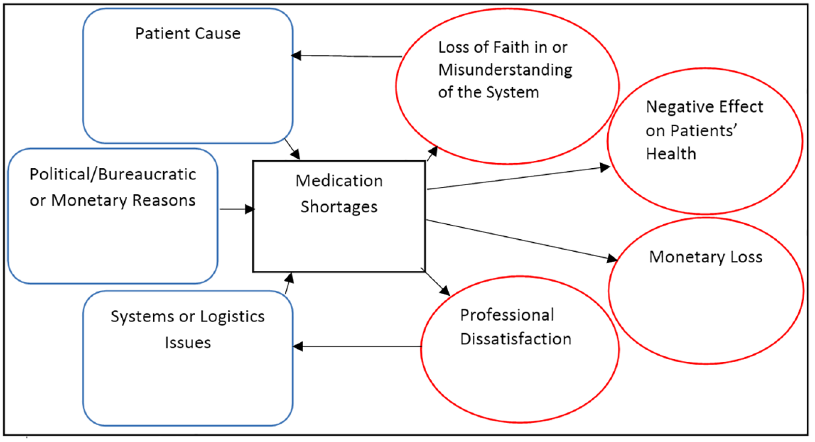
Fig 3. Summation of the causesand impacts of shortages expressedas an influence diagram. The arrows represent the influence one aspects holds over another.